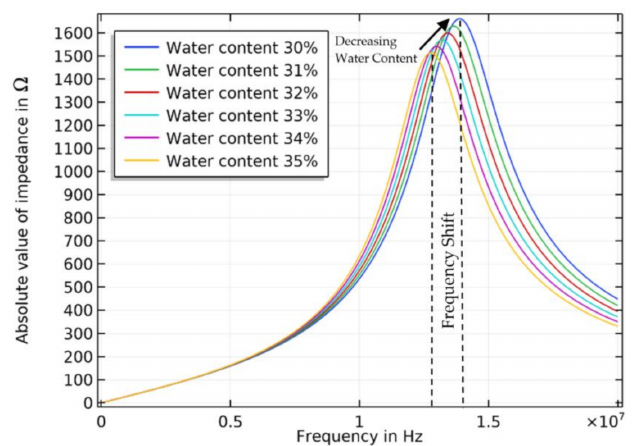
Figure 5. Simulation results of the absolute value of flat coil impedance as a function of frequency at different volumes of water content.